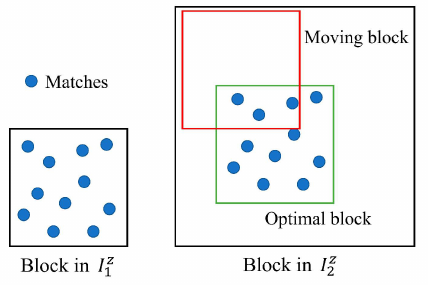
Figure 3. Post processing.